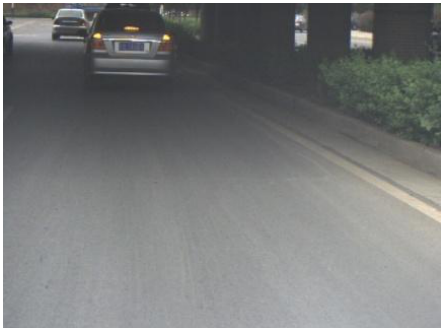
Figure 9. Shadow underneath the vehicle is covered by the shadow under the overhead